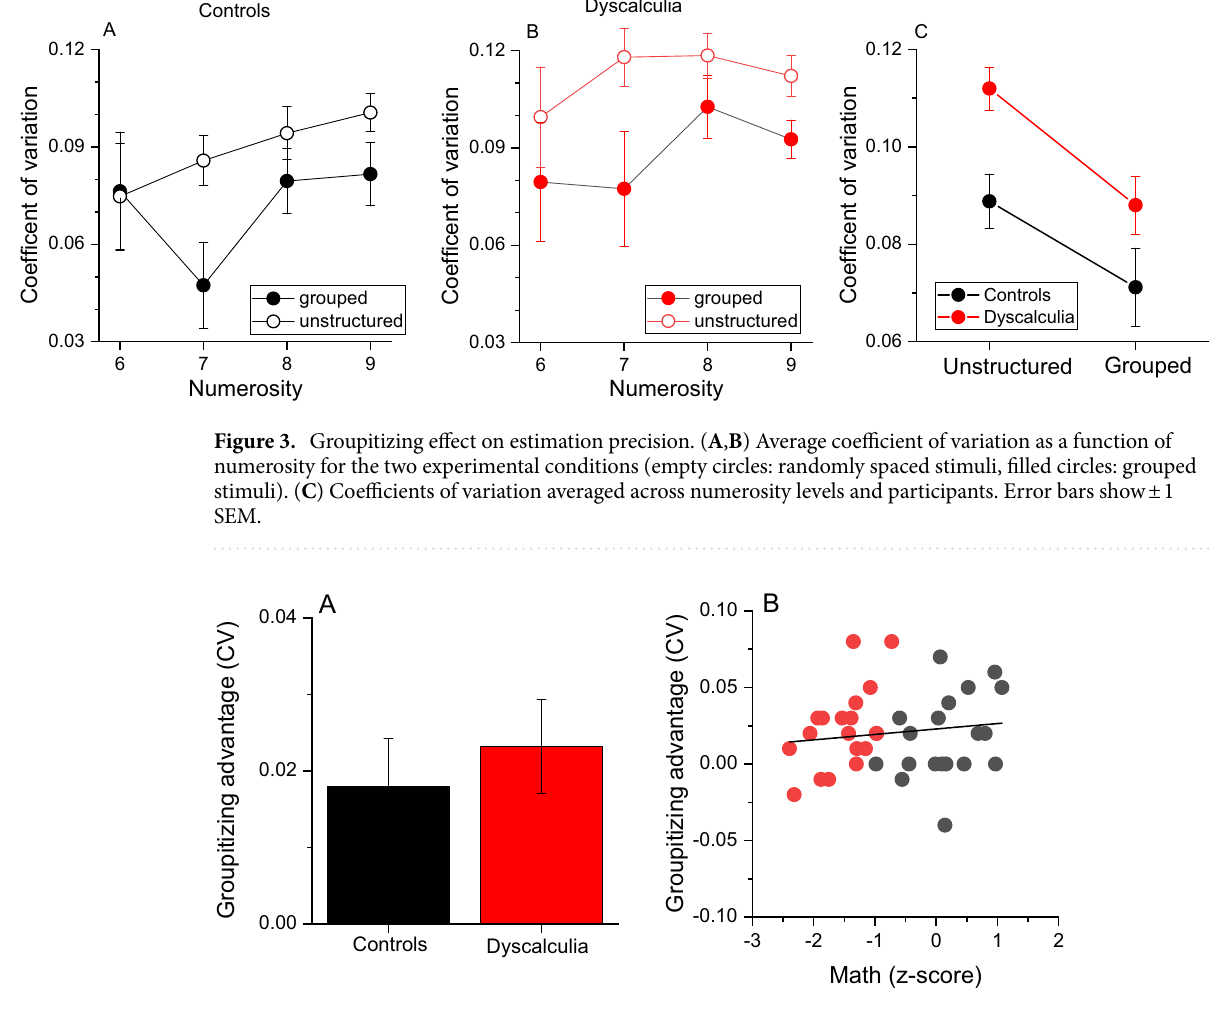
Figure 4. Groupitizing advantage on sensory precision. ( A ) Average standardized difference between precision ( CV , Eq. 1) for grouped and ungrouped stimuli in the sample with dyscalculia and controls. Error bars show ± 1 SEM. ( B ) Linear correlation between groupitizing advantage on sensory precision and math